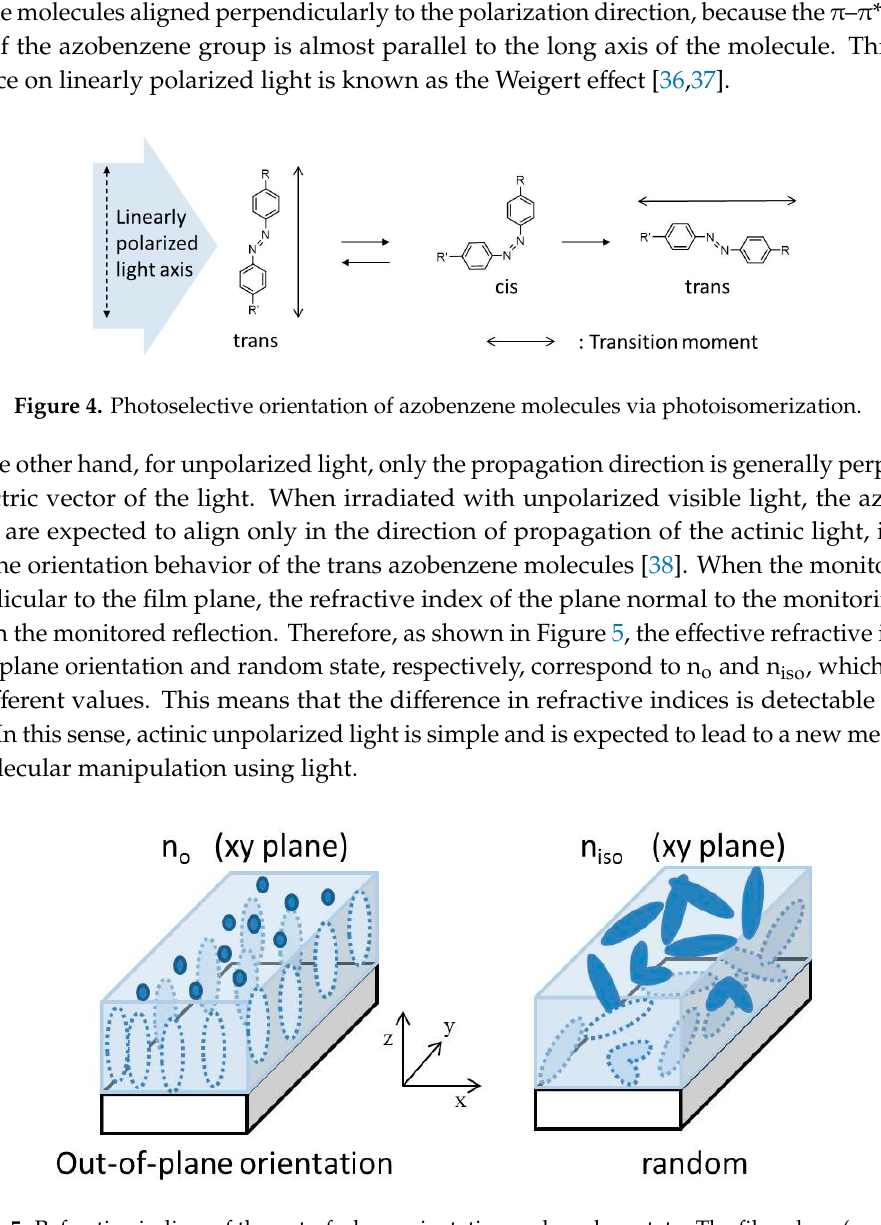
Figure 3. The refractive index change based on the molecular orientation of azobenzene liquid crystals (LC).